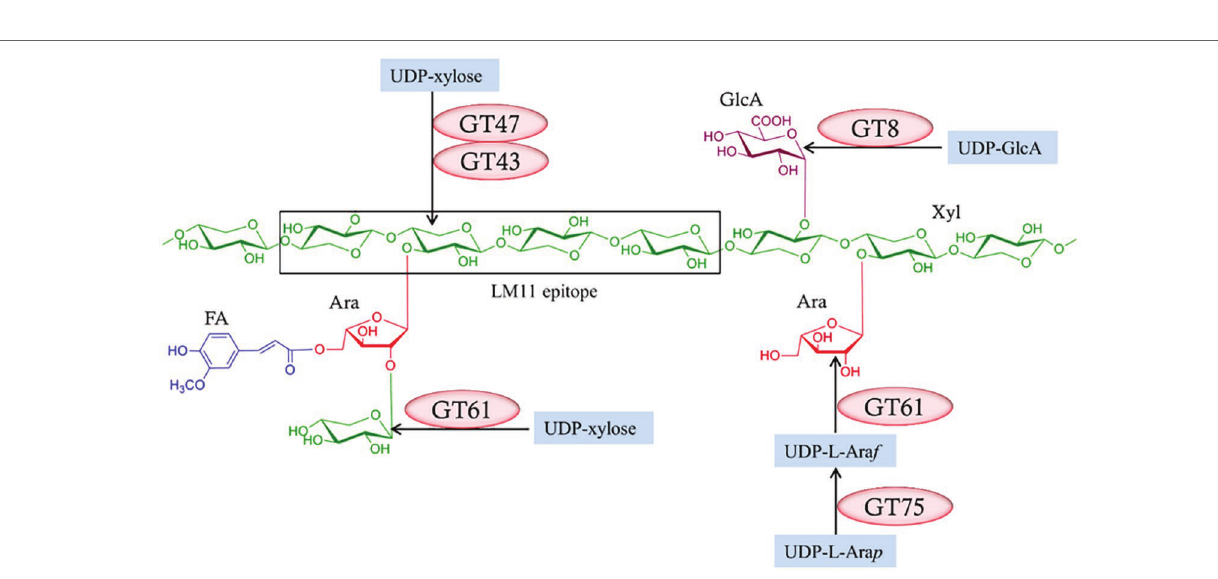
FIGURE 6 | Enzymes required for the biosynthesis of heteroxylans. Several enzymes from different glycosyl transferase (GT) classes (Lombard et al., 2014; http://www.cazy.org/) are required and these might vary between species. Reproduced from Chowdhury et al.